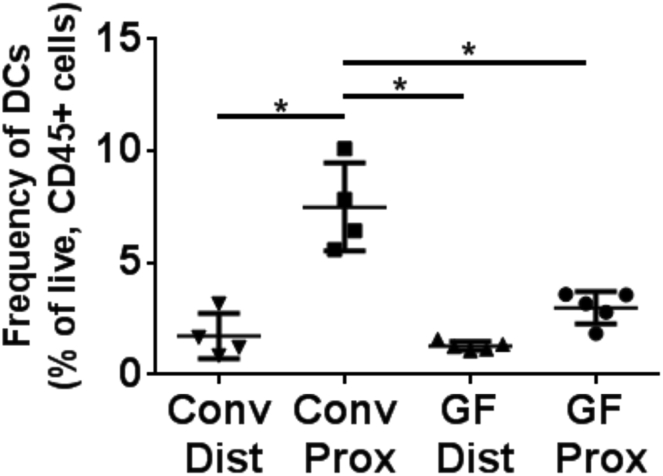
Dendritic cell (DC) compartmentalization in the murine colon is modulated by the microbiota. DC from proximal (Prox) and distal (Dist) regions of the colon in conventional (Conv) and germ-free (GF) mice were identified by flow cytometry within single colonic viable cells (ZombieAQUA−CD45+) and mean frequencies (with standard deviation) displayed. The results are representative of two independent experiments (n = 5 mice per group in each experiment). One-way analysis of variance with Tukey’s multiple comparisons was applied, and P < .05 was considered statistically significant (*P < .05, pair-wise comparisons without an asterisk were not statistically significant).